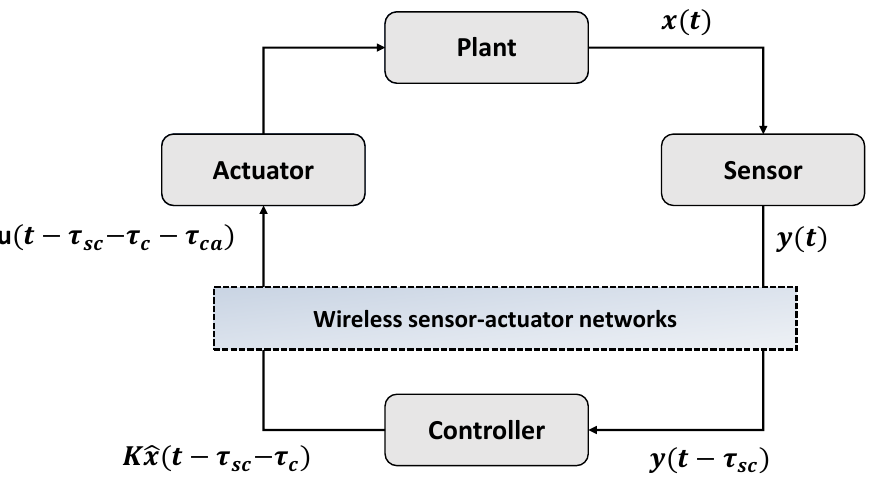
Figure 4. Network delay in